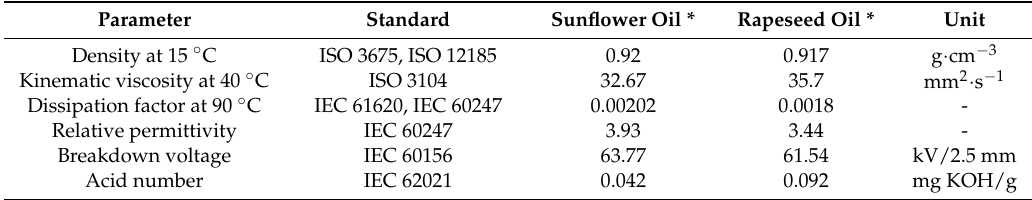
Table 1. Basic and required properties of untreated sunflower and rapeseed